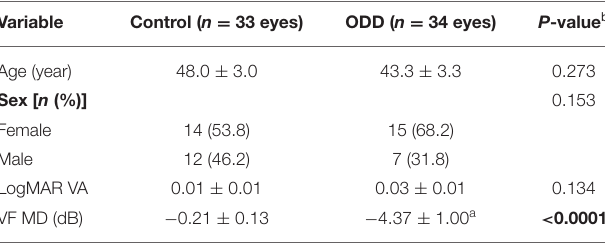
TABLE 1 | The demographics parameters of controls and patients (eyes) with optic disc drusen.